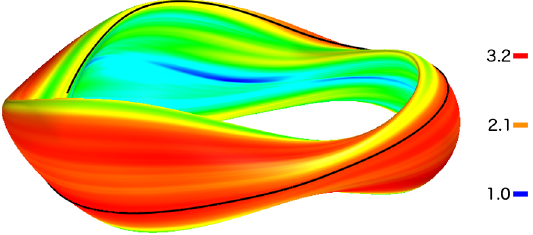
FIG. 3. Root-mean-squared normalized density fluctuations ¼ 2 Þ on the magnetic surface caused by ITG turbulence ð 1 =L T i FIG. 5. Root-mean-squared normalized density fluctuations of a tokamak in the small- ρ (cid:3) regime. For these parameters, ¼ 2 Þ on the magnetic surface ρ (cid:3) ¼ 4 = 250 is found to be adequate to obtain the small- ρ (cid:3) limit. caused by ITG turbulence ð 1 =L T i of the QUASAR stellarator in the large- ρ (cid:3) regime. The locali- Unlike the stellarator in the same regime, strong fluctuations zation pattern is lost and the fluctuations appear spread out on the cover the entire outboard side of the surface, where the excitation surface, as in the tokamak of the ITG turbulence is favored.